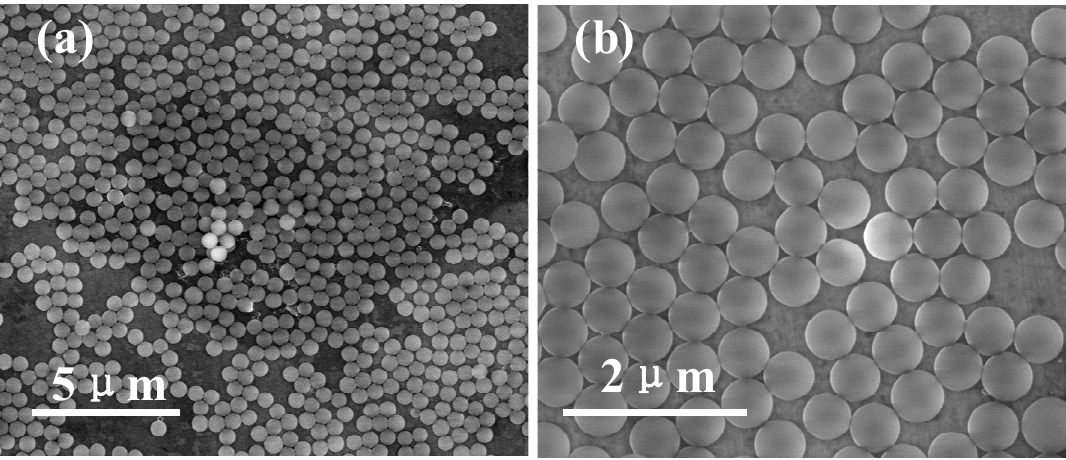
Figure 2. ( a ) SEM of diamond with a layer of 500 nm diameter balls of SiO 2 . ( b ) Magnification of ( a ).